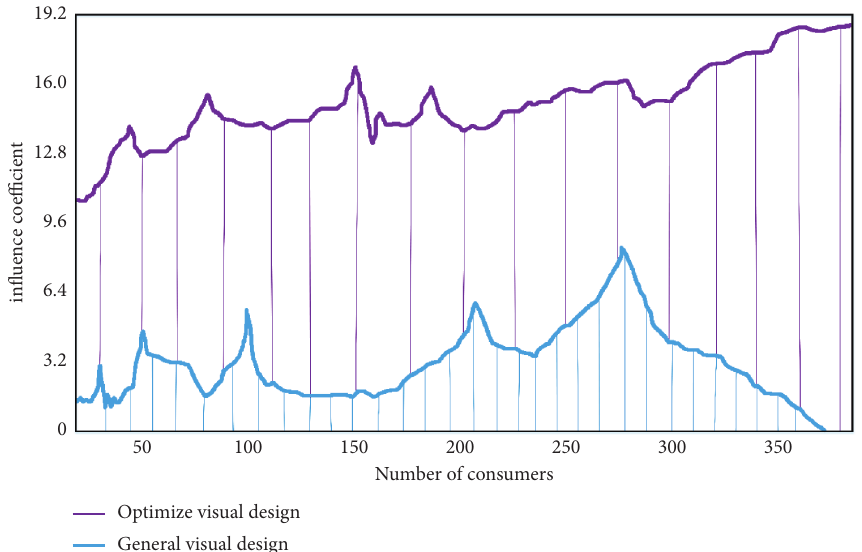
Figure 1: The impact of good visual design and ordinary visual design on consumers’ purchase